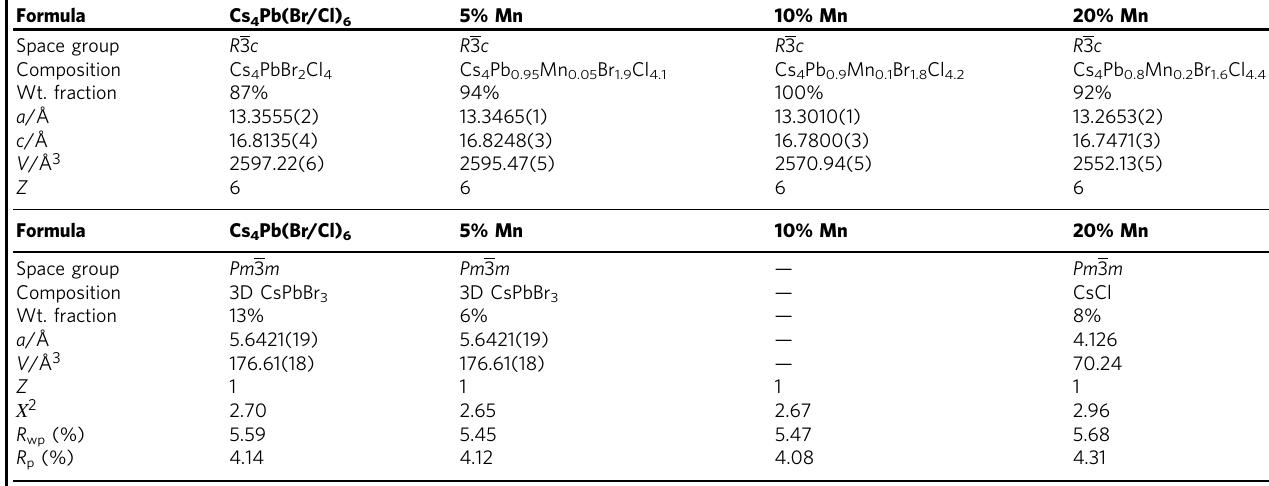
Table 1 Structural parameters of Cs 4 Pb(Br/Cl) 6 with varying concentration of Mn, calculated using the Rietveld re fi nement